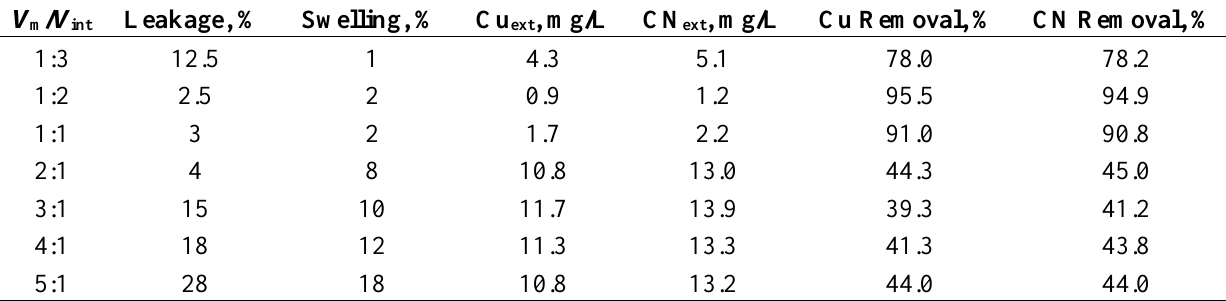
Table 1. Effect of volume ratio of membrane to internal phases on ELM stability and copper and cyanide removal. (For ELMs formation, membrane phase: 2% v / v 1-dodecanol, 1% v / v liquid paraffin, balanced with kerosene; Internal phase: 0.05 mol/L KOH